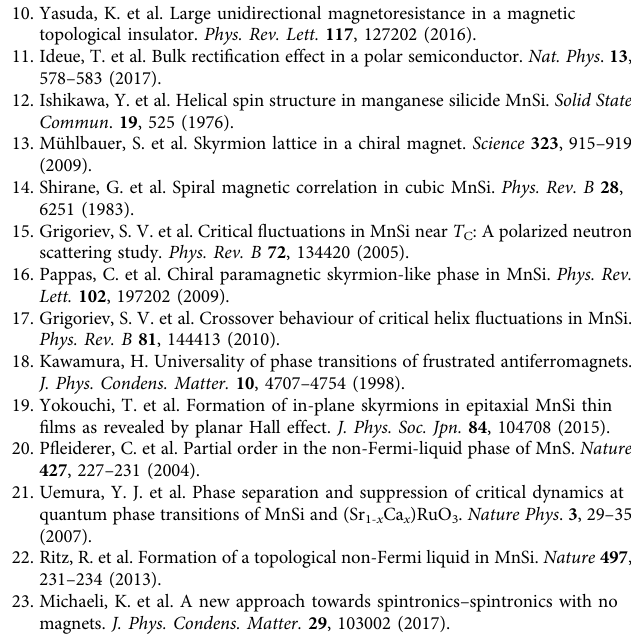
Transport measurements . Linear longitudinal resistivity and Hall resistivity were measured by using dc-transport option of Physical Property Measurement System (PPMS). Hydrostatic pressures were applied with use of a CuBe clamp cell, and the applied pressures were calibrated with pressure change of superconducting transition temperature of Pb. Second harmonic resistivity was measured by using a Lock-in technique (SR-830, Stanford Research Systems); we input low-frequency ( f ) ac current and measured second harmonic resistivity.